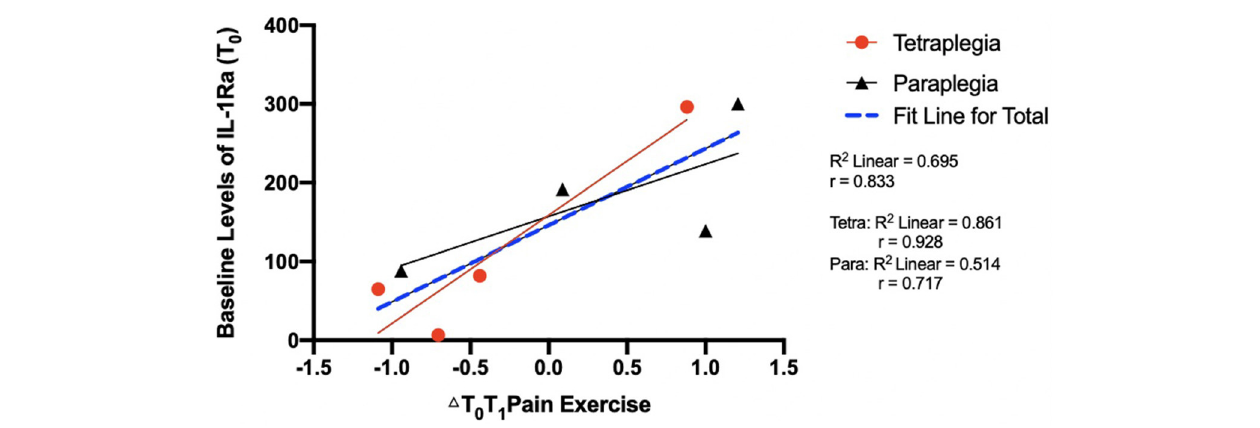
FIGURE 3 | Scatterplot of baseline levels of IL-1Ra and changes in neuropathic pain between T 0 T 1 .